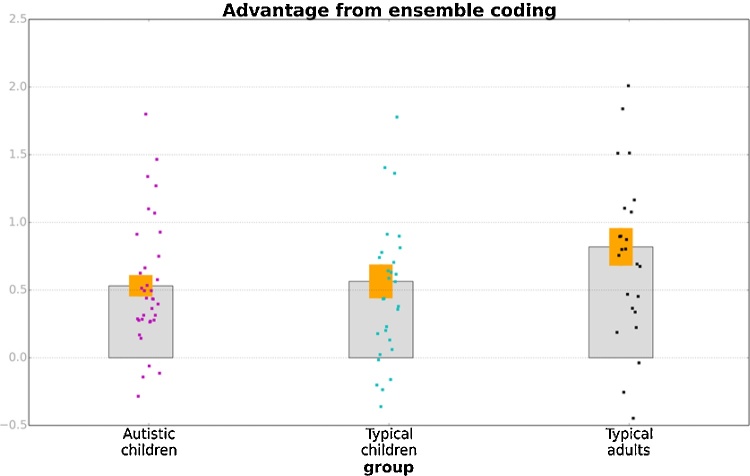
Ensemble coding advantage in the three groups of participants. Orange bands correspond to ±1 SEM, while points superimposed on bars show individual variability.